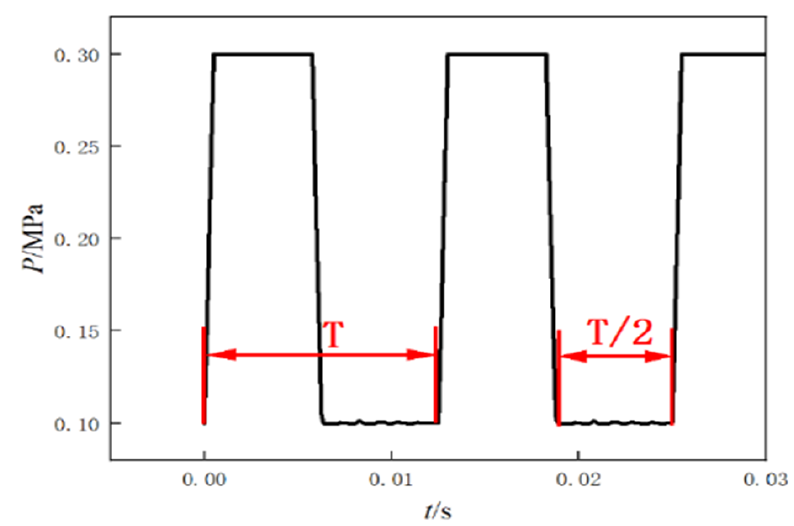
Figure 4. Trapezoidal total pressure waveform of external stimulation flow.